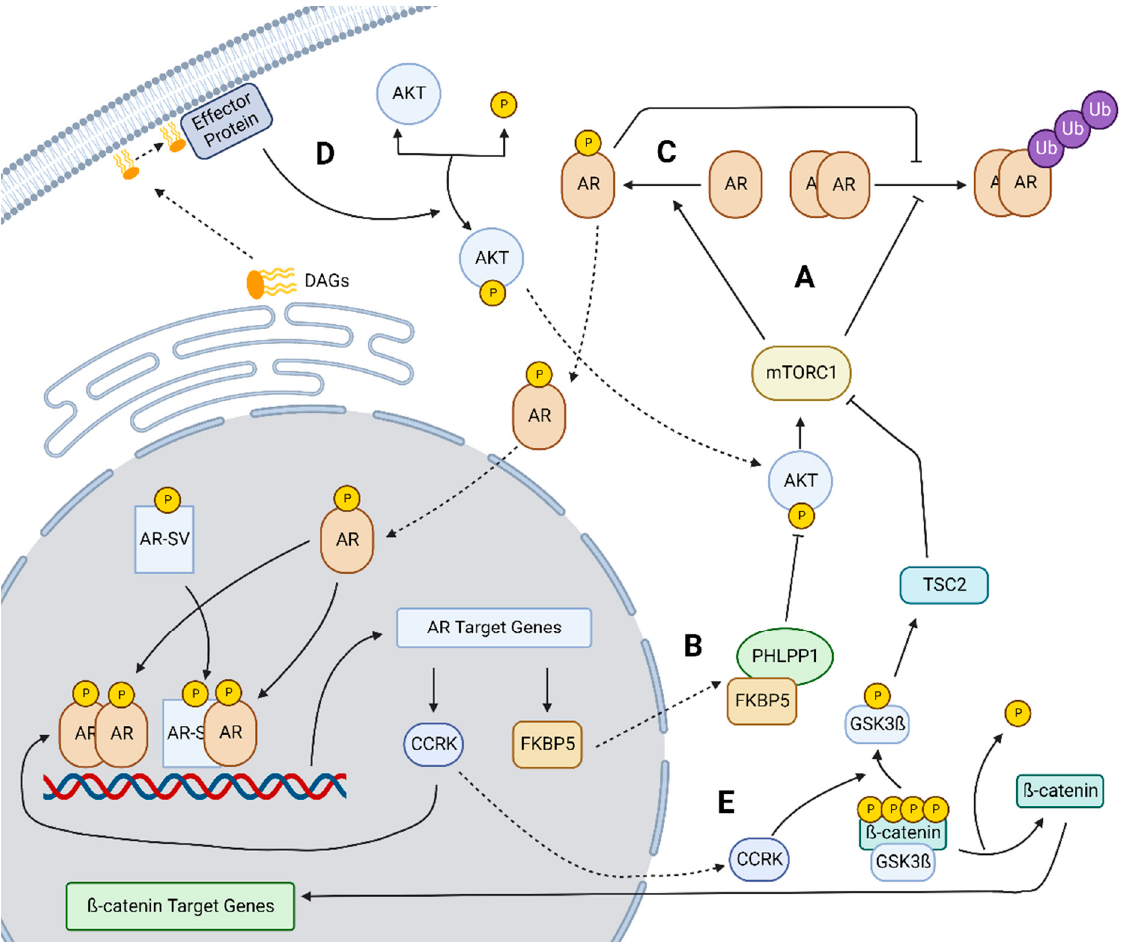
Figure 3. Map of mechanisms of inducing AR expression in HCC showing linkages to mTOR, lipogenesis, and CCRK-mediated signaling. The splice variants shown demonstrate a non-androgen- mediated pathway of AR signaling, however, the effects of AR-SV signaling may not be directly in line with AR-FL signaling and further study is warranted to elucidate the impacts of AR-SVs on these pathways. (A) mTORC1 interacts with AR by both inhibiting AR degradation and upregulating AR activity. (B) AR-FL target gene FKBP5 scaffolds onto PHLPP1, an AKT phosphatase, to inhibit AKT phosphorylation by extension mTORC1 activity forming a feedback loop. (C) mTORC1 upregulates AR activity by phosphorylating AR at serine 96. (D) Specific DAGs from lipogenesis can increase Akt activity through binding at an unknown effector protein leading to increased AKT -mediated AR activity. (E) CCRK phosphorylates GSK3ß deactivating it, which leads to both activation of β -catenin and inhibition of TSC2 by preventing its phosphorylation by GSK3ß. Figure created in BioRender.